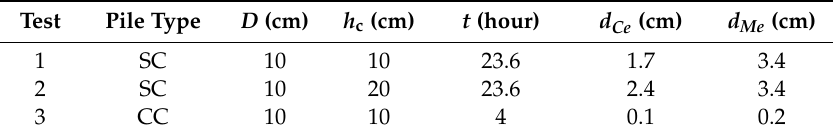
Table 2. List of